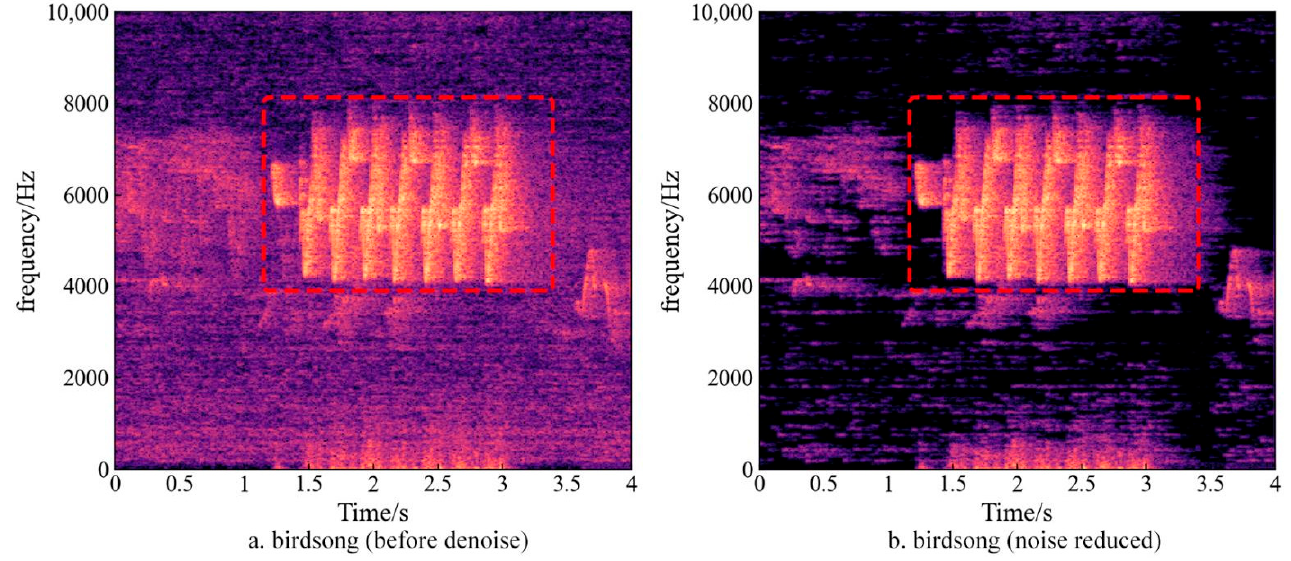
Figure 3. Birdsong spectrum before and after noise reduced. Red rectangle highlighting the frequency spectrum of birdsong. ( a ) Birdsong frequency spectrum before noise reduced; ( b ) birdsong frequency spectrum after noise reduced, noise-reduction processing significantly enhances the noise signal ratio.